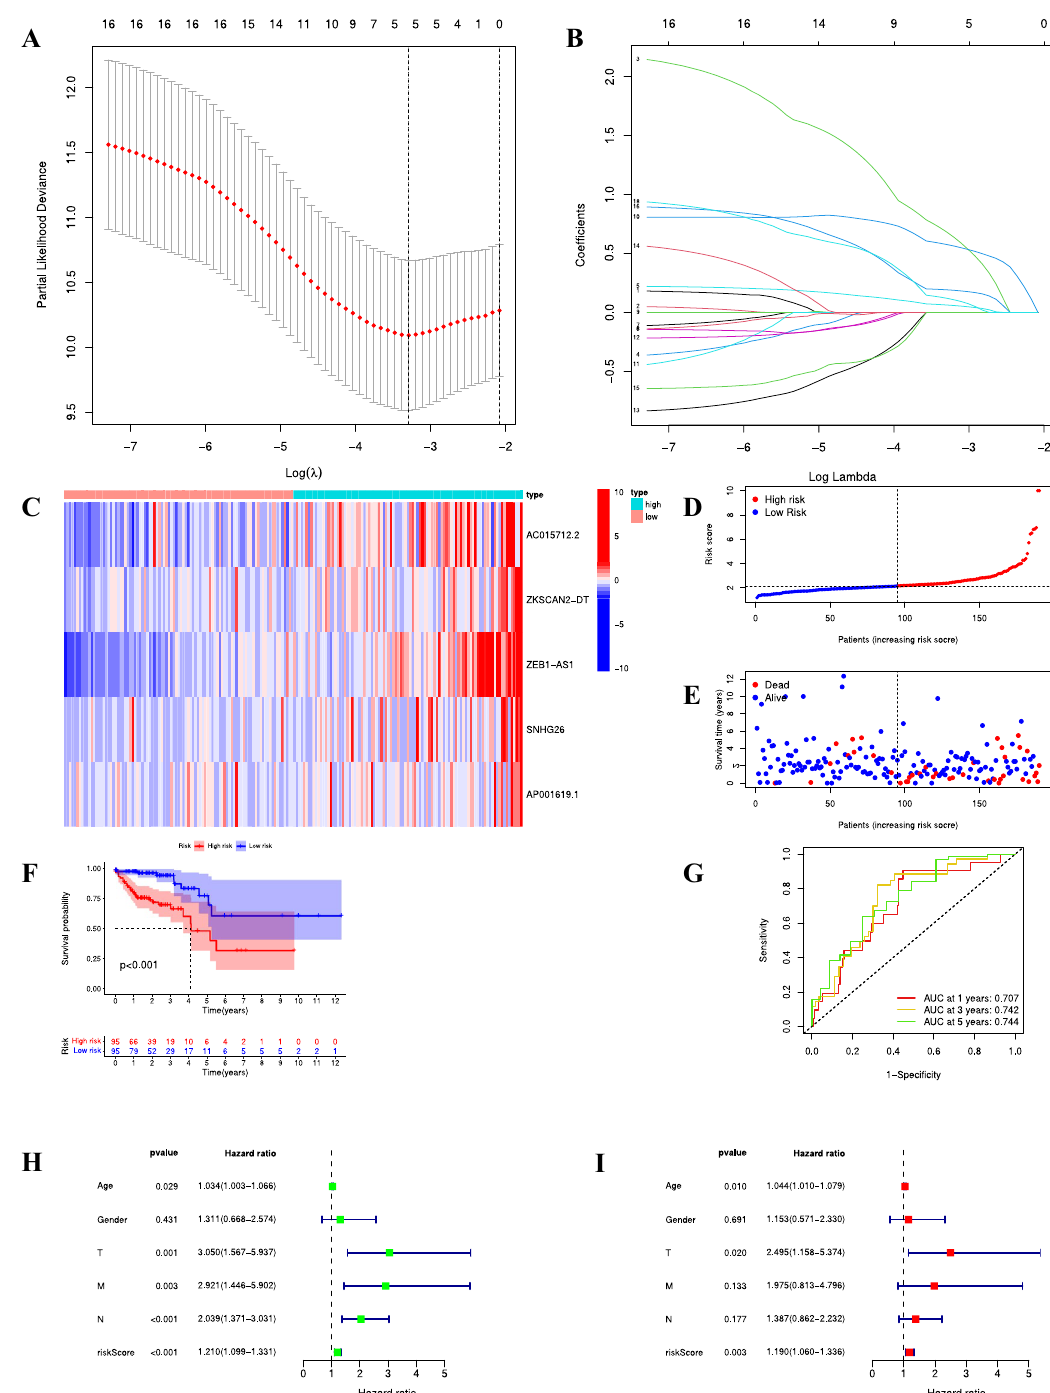
Figure 6. Construction of prognostic CRL signature. ( A , B ) Least absolute shrinkage and selection operator (LASSO) regression analysis with the most optimal lambda value. ( C ) Expression of five CRLs between high- and low-risk groups in the training cohort. ( D , E ) Distribution of risk score and survival states for all COAD patients in the training cohort. ( F ) Kaplan–Meier curves of OS based on the risk score in the training cohort. ( G ) Receiver operating characteristic (ROC) curve analysis in the training cohort. ( H , I ) Univariate Cox regression analysis ( H ) and multivariate Cox regression analysis ( I ) in the training